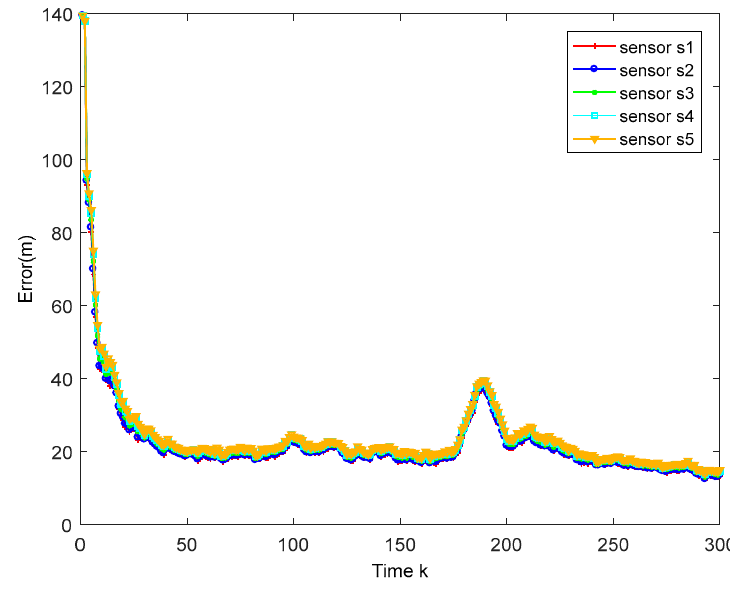
Figure 4. Position RMSE of different sensors.